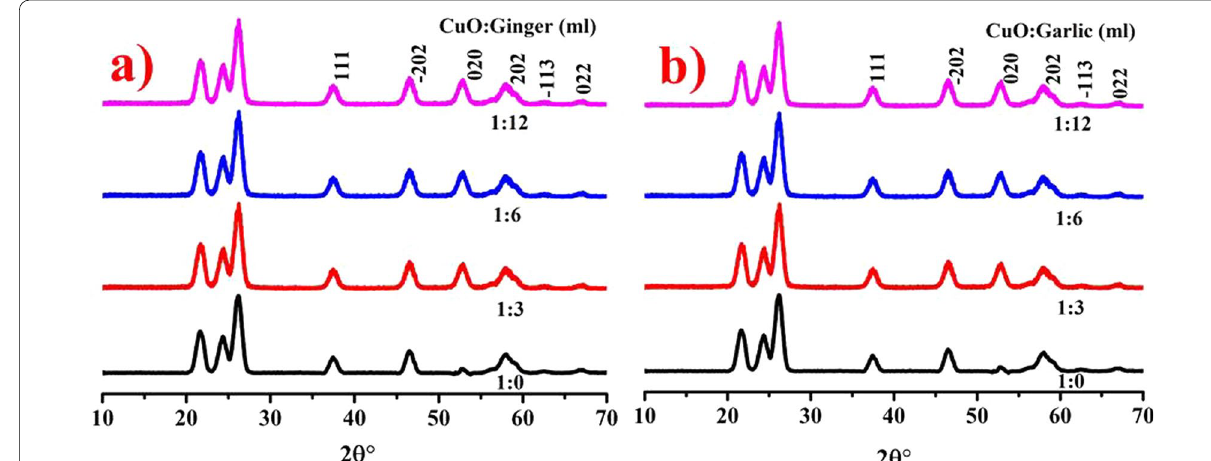
Fig. 3 XRD patterns of CuO NPs without and with doping of a AS b ZO